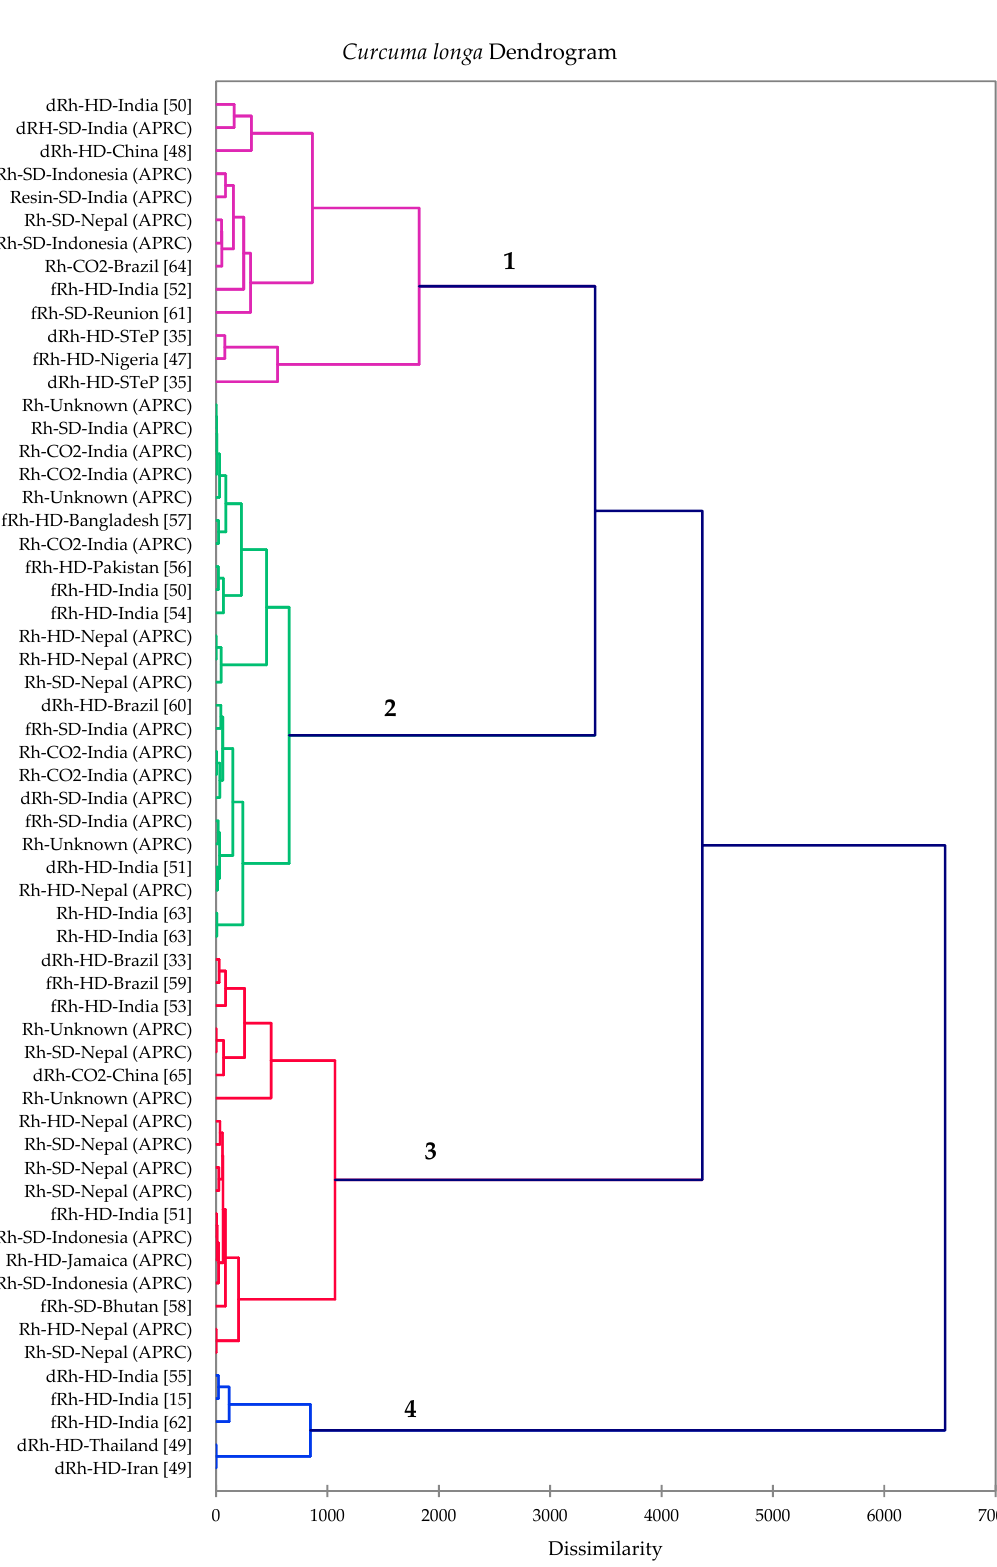
Figure 1. Dendrogram obtained from the agglomerative hierarchical cluster analysis of 60 Curcuma longa volatile oil samples.